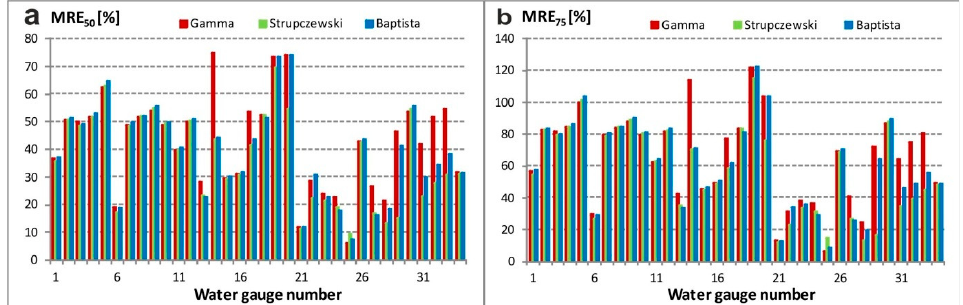
Figure 7. Mean relative errors of hydrograph width W p : ( a ) p = 50%, ( b ) p = 75%. Correlation coefficient (r), root mean square error ( RMSE ) and mean absolute error